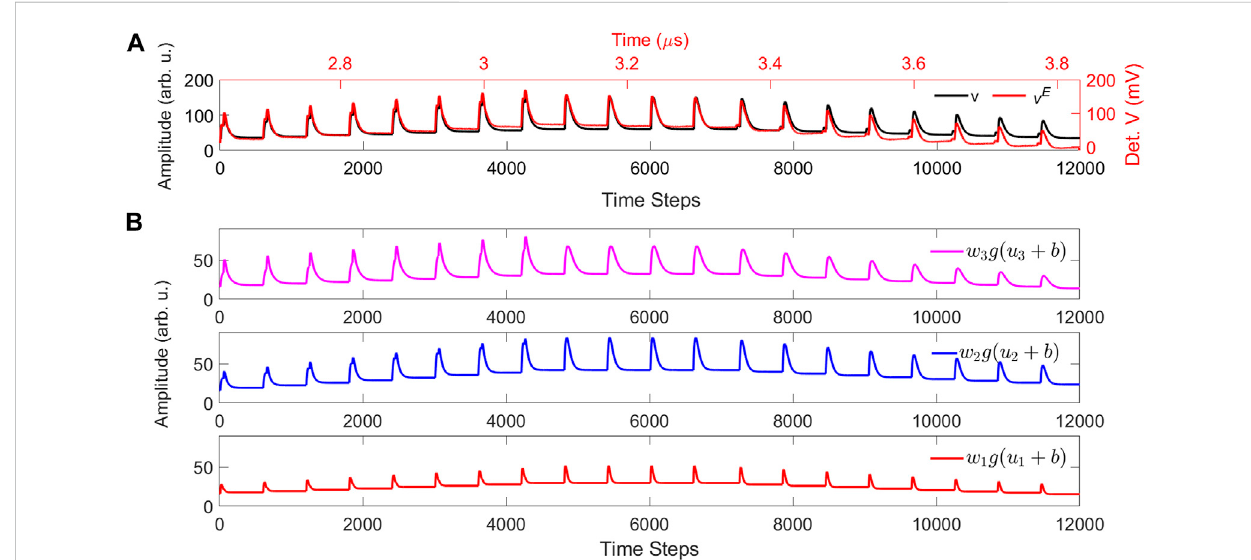
FIGURE 10 (A) Comparison between numerical simulations ( v , black color) and experimental results ( v E , red color) of the ICO rule ’ s output, with one stimulus signal x 1 that feeds three activation fi lters ( u 1 − u 3 ). In the numerical model, the gain is g =2 and the bias is b =8. “ Det. V ” is the abbreviation for “ Detected Voltage. ” (B) The numerically computed weighted stimulus input signals, for the previous values of gain g and